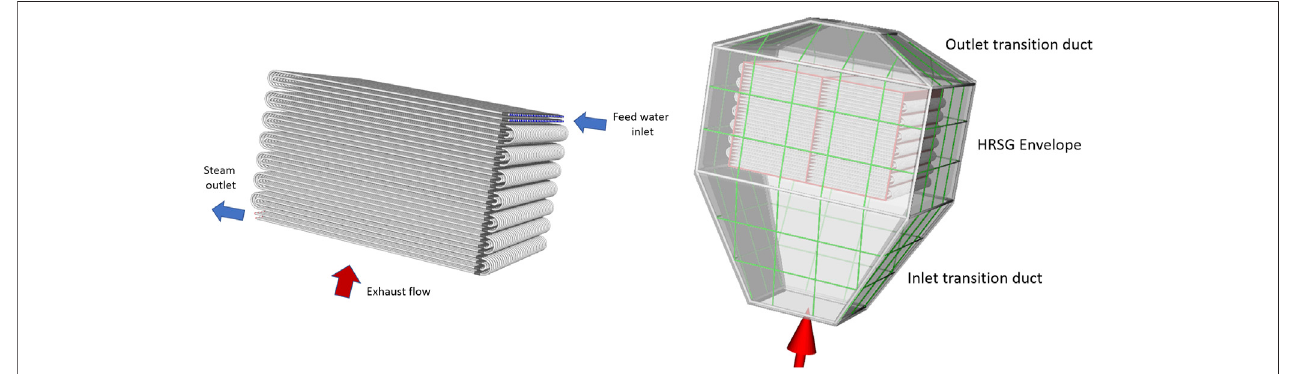
FIGURE3| Geometry visualizationofa3DtubebundlefortheOTSGcoreand howthetube bundleissituated insideacasing.Totheright, thestructural elements are shown in a schematic way including duct plates (three layers with an inner lining of 2 mm steel plates, an insulation layer, and the outer duct of 10 mm steel plates), beams (green lines), heat exchanger frame, and the support plate(s) (in red).